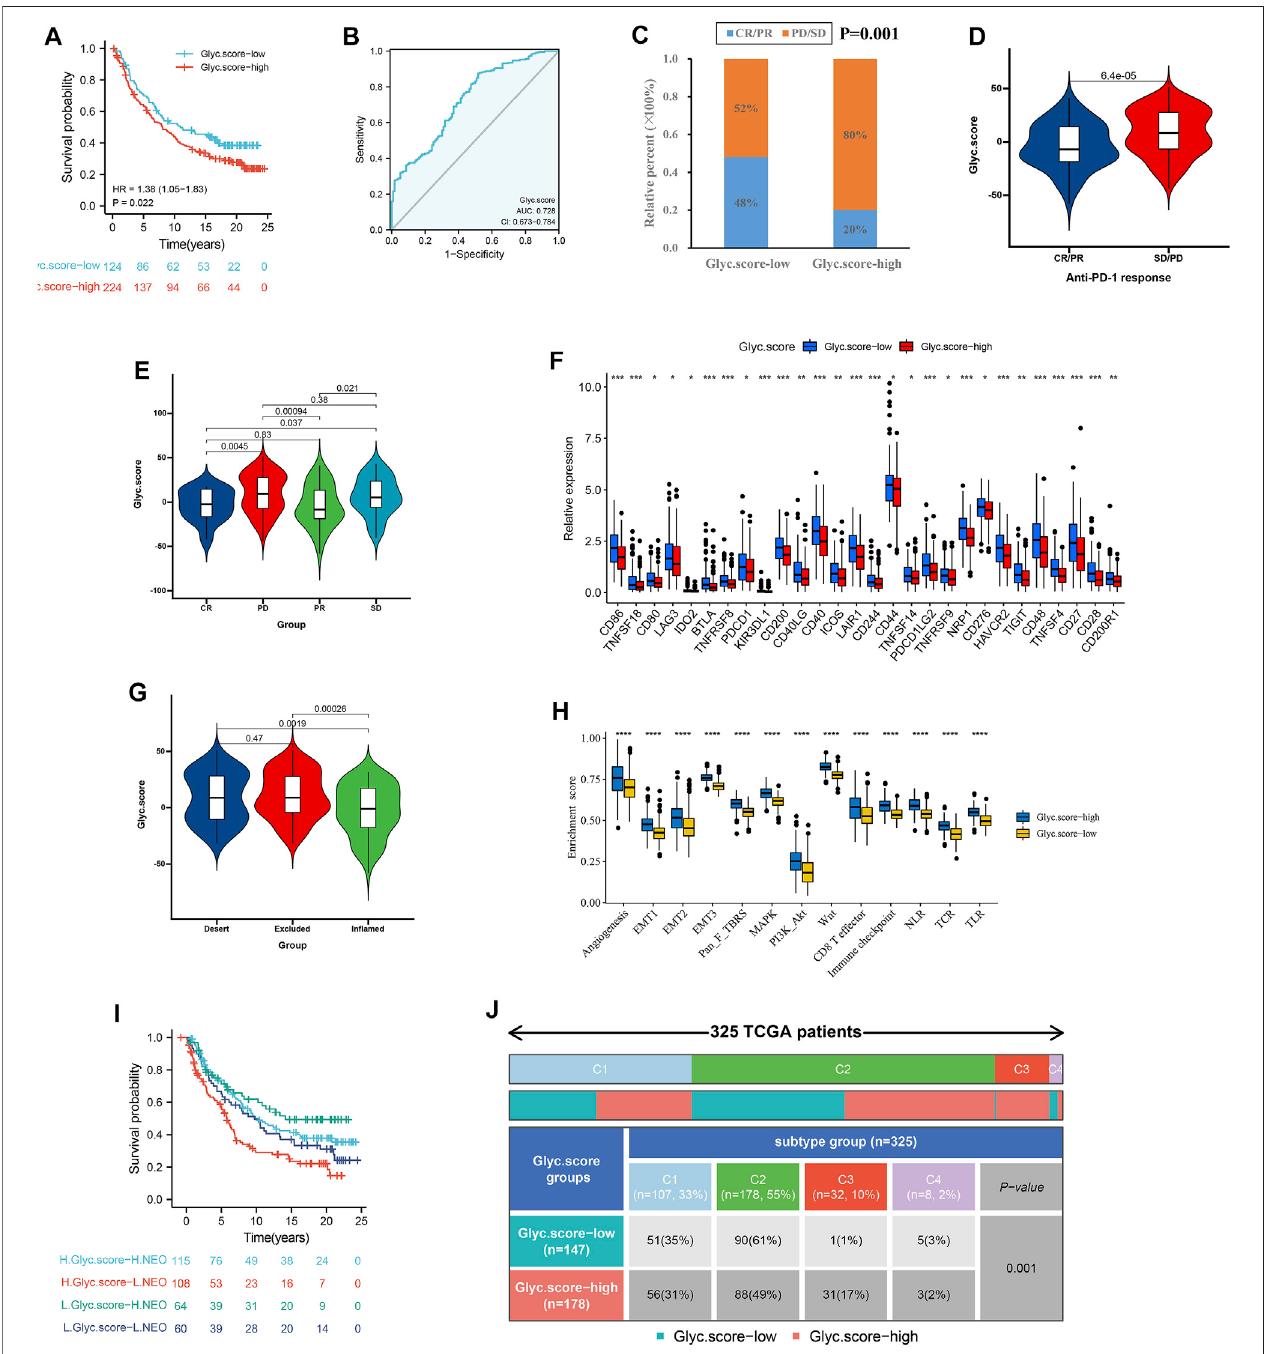
FIGURE 8 | Glyc. score in the role of anti – PD-1/L1 immunotherapy. (A) Survival analyses for low – and high – Glyc. score patient groups in the anti – PD-L1 immunotherapy cohort using Kaplan – Meier curves (IMvigor210 cohort). (B) The predictive value of Glyc. score in IMvigor210 cohort. (C) The proportion of patients with response to PD-L1 blockade immunotherapy in low – or high – Glyc. score groups. SD, stable disease; PD, progressive disease; CR, complete response; PR, partial response. (D) Differences in Glyc. score among distinct anti – PD-1 clinical response groups. (E) Distribution of Glyc. score in distinct anti – PD-L1 clinical response groups. (F) Differencesincheckpointexpressionbetweenlow – andhigh – Glyc.scoregroups. (G) DifferencesinGlyc.scoreamongdistincttumorimmunephenotypesin IMvigor210cohort. (H) DifferencesinstromaactivatedpathwaysandabundanceofregulatoryTcells(consideredasimmunesuppression)betweenlow – andhigh – Glyc. score groups in anti – PD-L1 immunotherpy cohort. (I) Survival analyses for patients receiving anti – PD-L1 immunotherapy strati fi ed by both Glyc. score and neoantigen burden using Kaplan – Meier curves. NEO, neoantigen burden. (J) Differences in Glyc. score between immune subtypes (C1, wound healing; C2, IFN-gamma dominant; C3, in fl ammatory; C4, lymphocyte depleted).